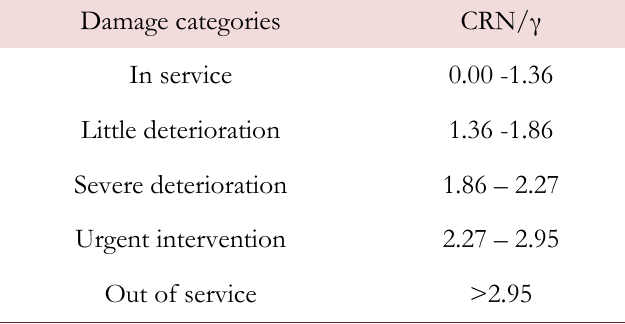
Table 3: Damage categories for the proposed